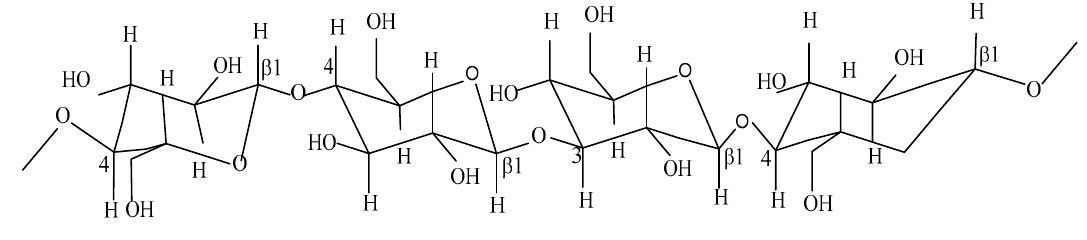
Figure 1. Molecular structure of β‐ glucan.